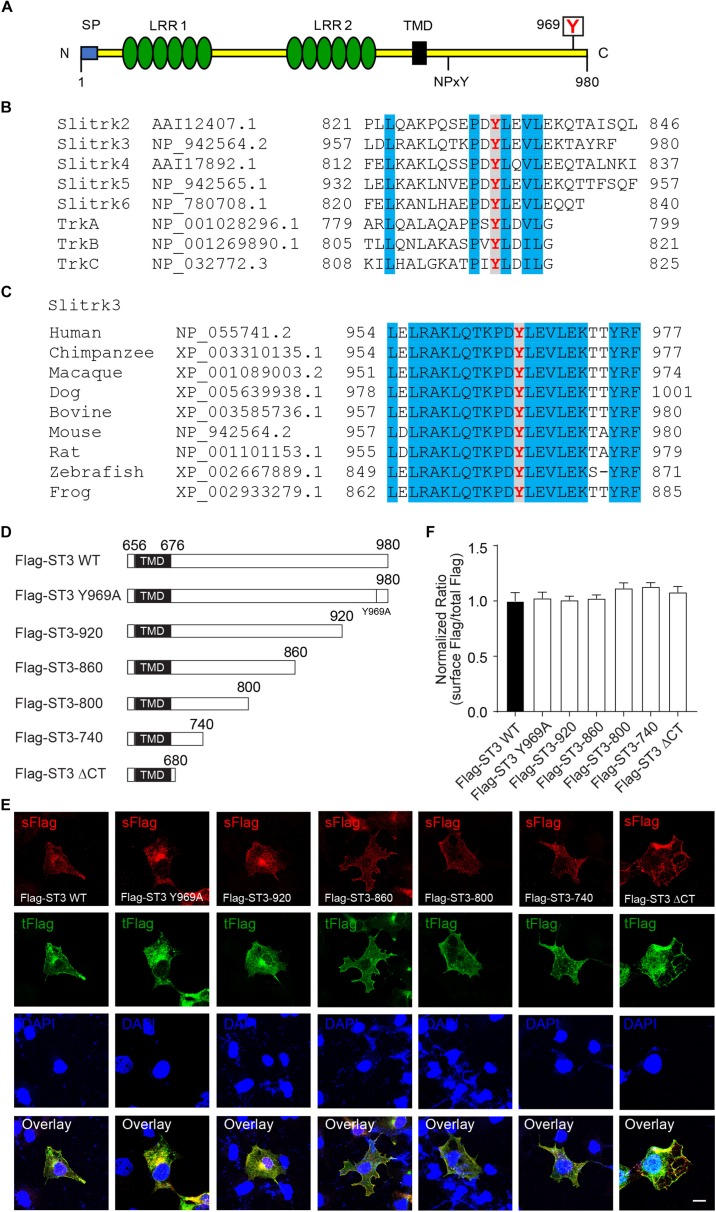
ST3 C-terminus is not necessary for surface expression of ST3 in heterologous cells. (A) Schematic of ST3 showing LRR1 and LRR2 clusters in its extracellular region, and the intracellular conserved tyrosine residues. N, N-terminus; C, C-terminus; SP, signal peptide; LRR1, leucine-rich repeats cluster 1; LRR2, leucine-rich repeats cluster 2; TMD, transmembrane domain; NPxY, NPxY motif; boxed Y, a conserved tyrosine residue in Slitrks and Trk receptors. (B) Amino acid sequence alignment of the C-termini of mouse Slitrk and Trk proteins. The tyrosine in red indicates the conserved residues (Y969 in mouse ST3) in Slitrks and Trk receptors, and residues in blue indicate other conserved amino acid residues between Slitrks and Trk receptors. (C) Cross species alignment of the ST3 C-termini. The tyrosine in red indicates the conserved residues (Y969 in mouse ST3) in ST3 C-termini from nine different vertebrate species, and residues in blue indicate other conserved amino acid residues across different species in the distal Slitrk3 C-termini. (D) Schematic of WT and C-terminal mutant forms of Flag-ST3. TMD, transmembrane domain. (E,F) Representative images showing surface (s) and total (t) Flag expressions of Flag-ST3 WT or Flag-ST3 mutants in COS7 cells. The ratios of surface to total fluorescent intensity were calculated and showed that ST3 C-terminus was not required for ST3 expression at the cell surface (n ≥ 14 for each group, One-way ANOVA test, p > 0.05, N = 3 independent experiments). Scale bar, 10 μm.